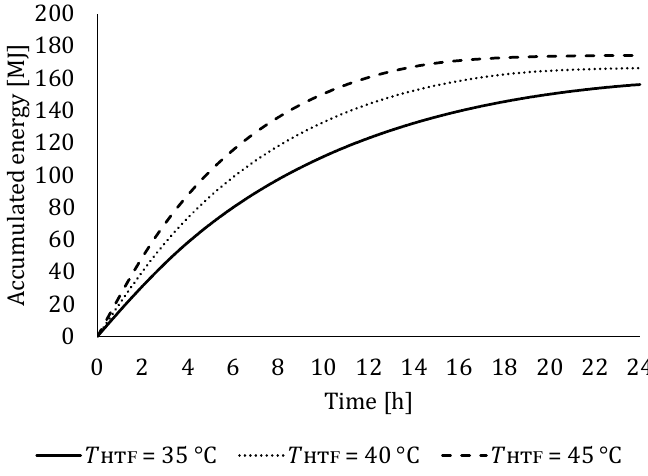
Figure 14. Comparison of accumulated energy during melting obtained numerically for different HTF inlet temperatures, HTF inlet flow rate 800 l/h and initial PCM temperature 15 °C.